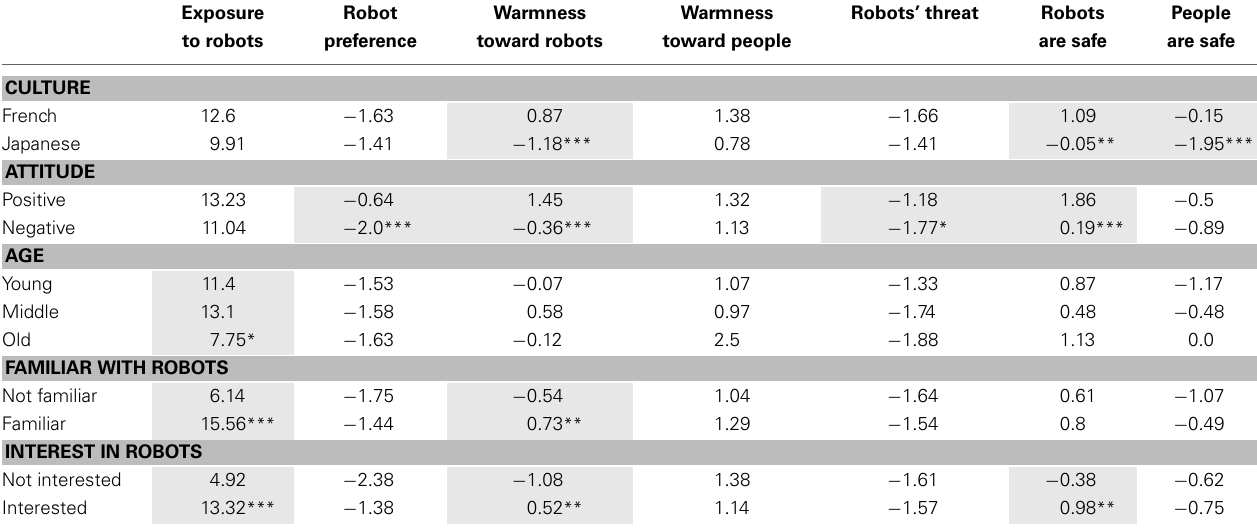
Table 1 | Attitudes toward robot and people per factor. Exposure